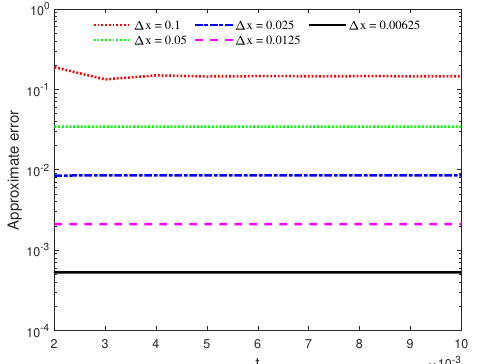
Figure 7. The evolution of the relative error in obtain the numerical solution of the problem (27) with various grid sizes by using the proposed method with T WJ – T GS – T SOR .